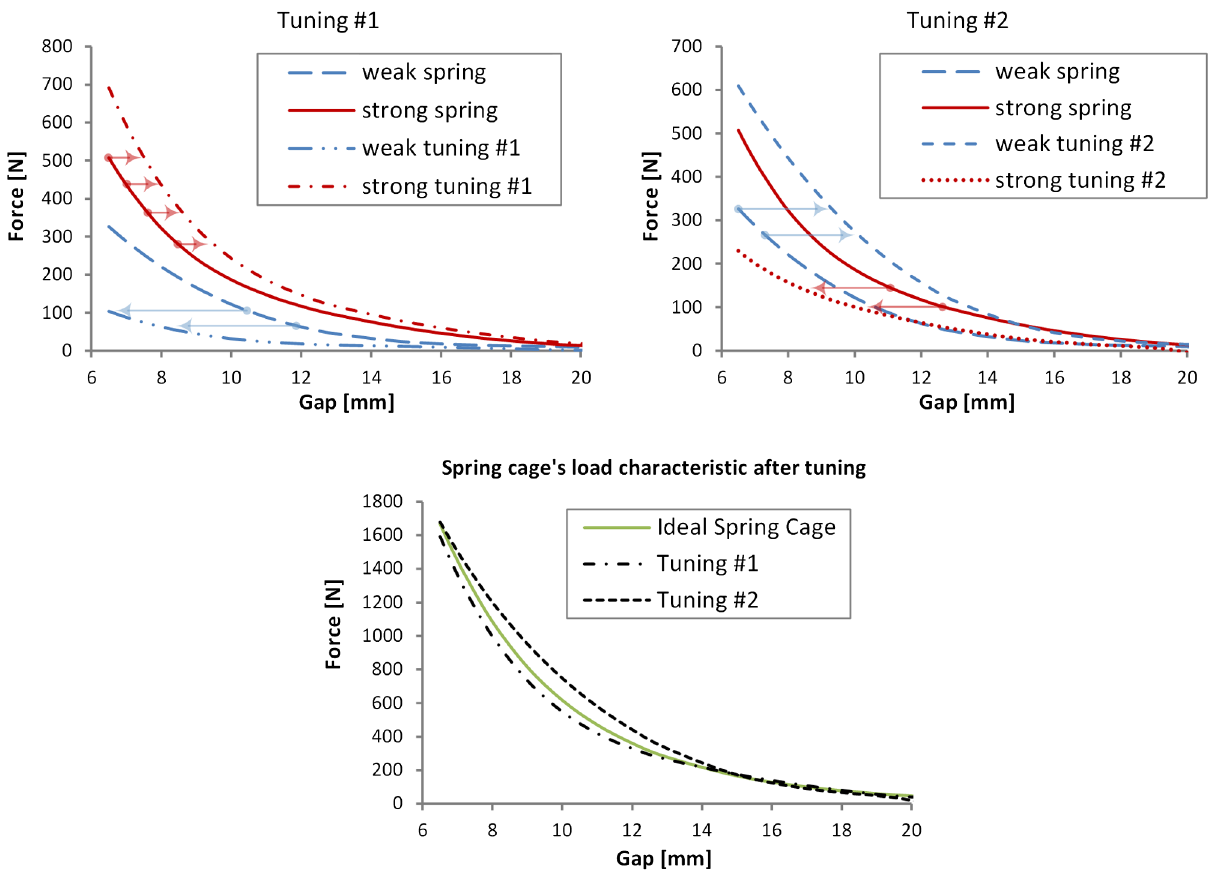
FIG. 13. An example of how the load characteristic of a spring unit can be tuned by adjusting the engagement point of the individual springs. A pair of springs — one strong, one weak — has its engagement points shifted one way in “ Tuning #1 ” and the other way in “ Tuning #2. ” The resulting total force from the pair of springs in both cases is shown in the bottom panel, along with the total force from the untuned pair of springs.